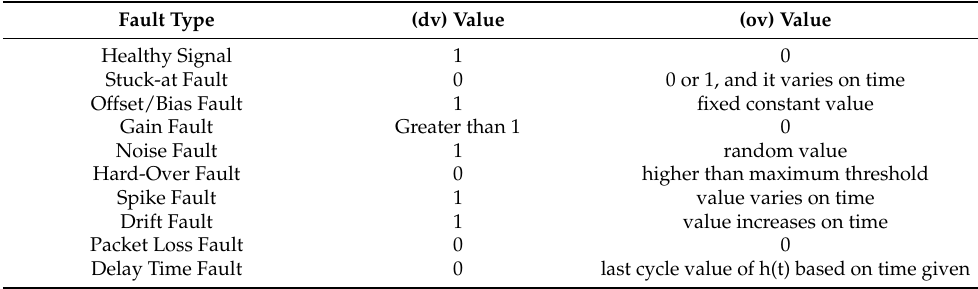
Table 2. Value of dv and ov for all fault